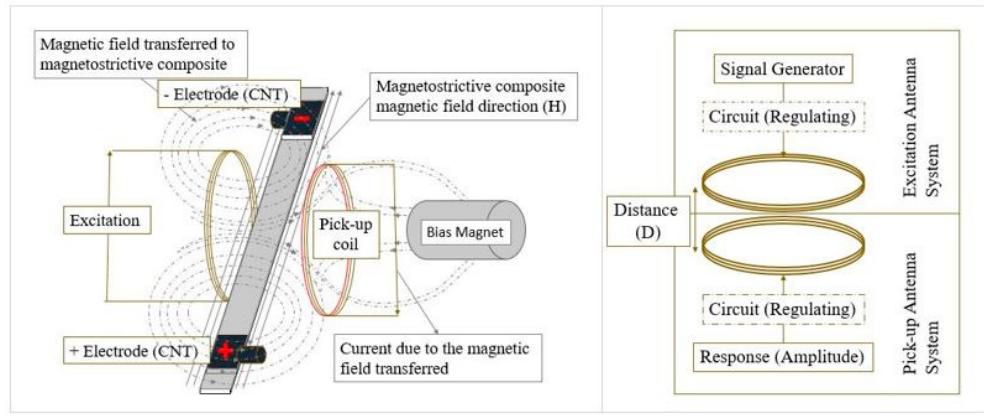
Figure 9. Working system of the designed magnetostrictive self-sensing smart composites detection system.